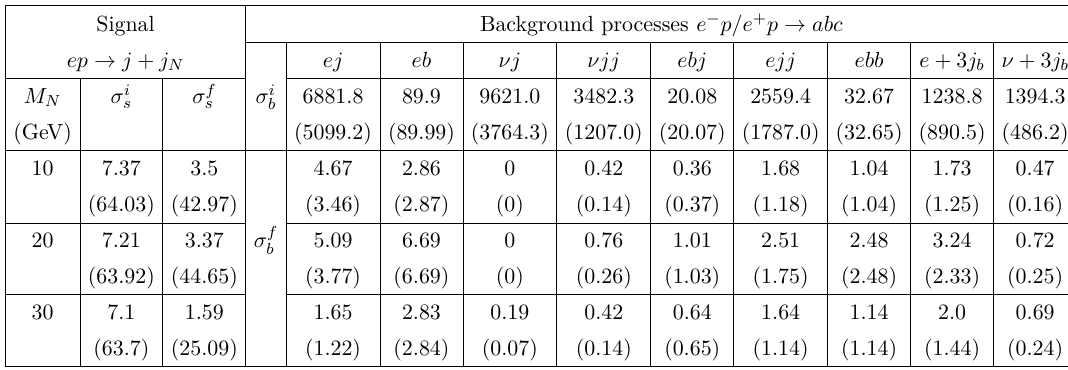
Table 1 . Initial and after cut cross-sections (in fb) for signal and backgrounds, which are denoted as σ i,f and σ i,f respectively. For background processes j s b numbers without (within) brackets are for e − ( e + ) mode,